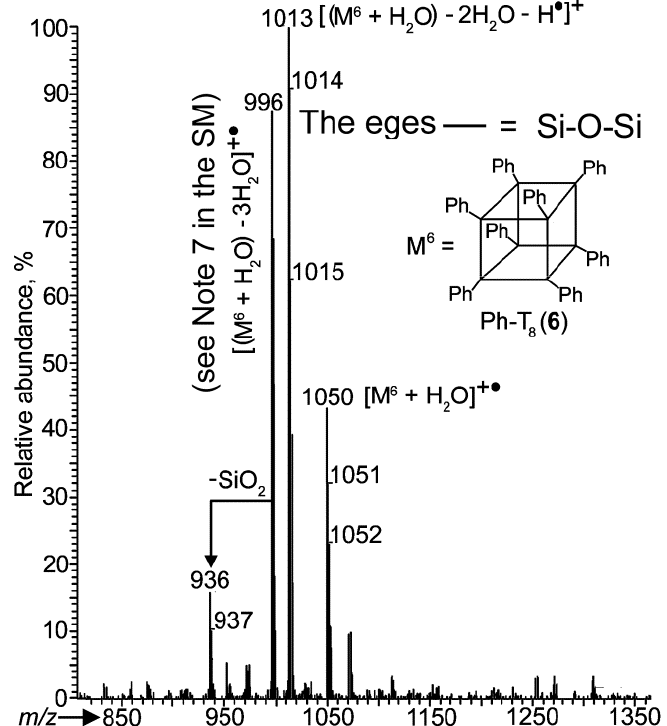
Figure 5. PI APCI mass spectrum of compound 6 .